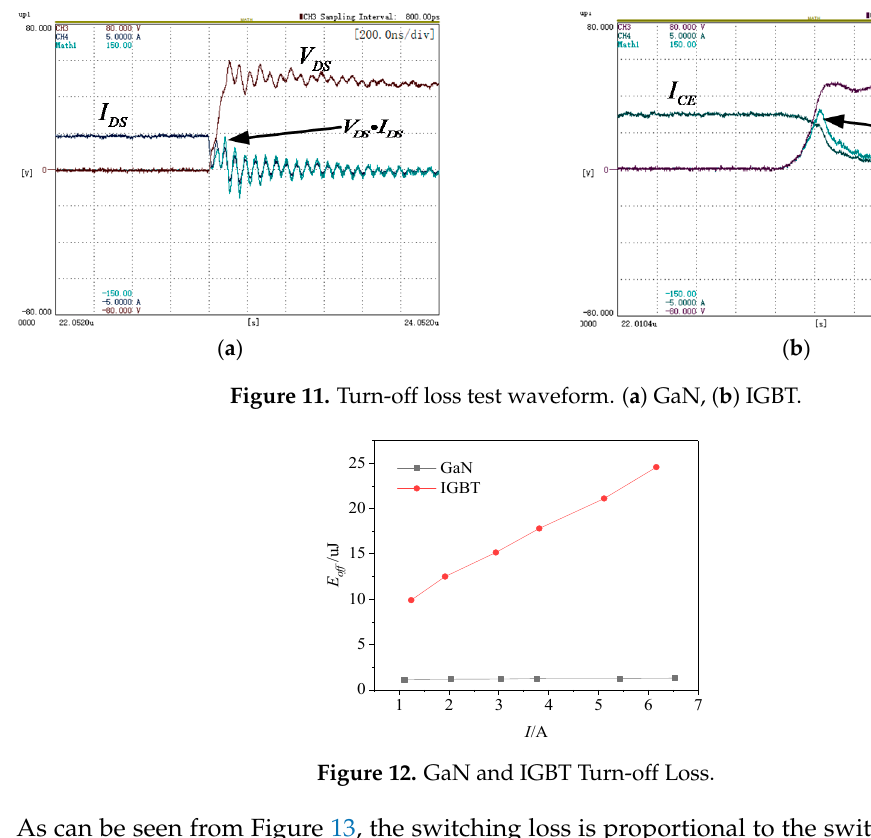
Figure 10. GaN and IGBT turn-on loss.